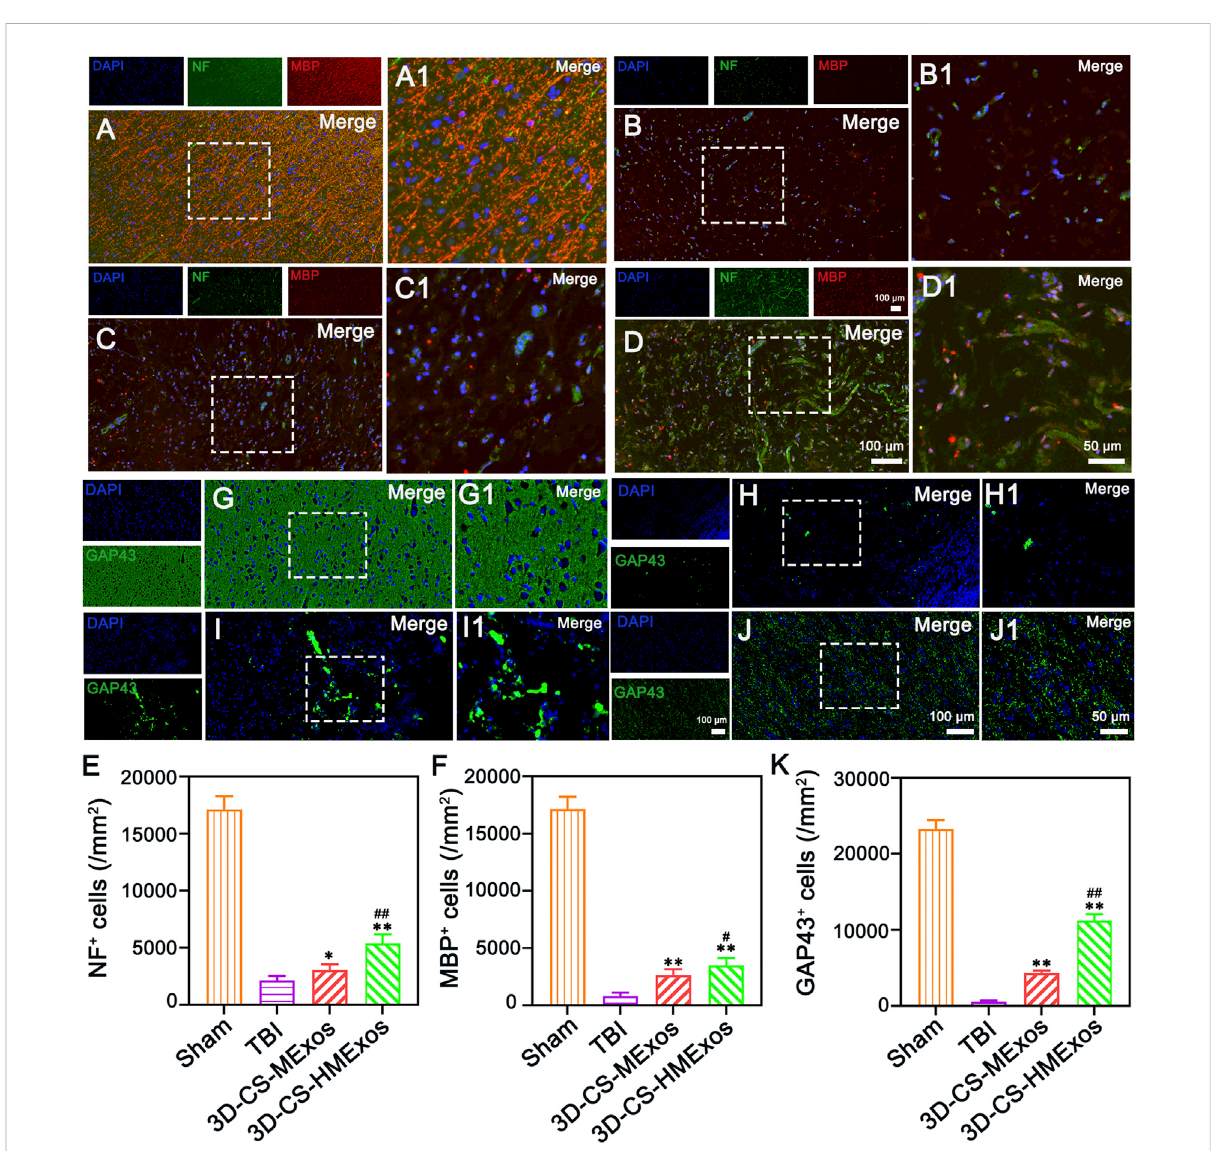
FIGURE 5 Nerve fi ber regeneration, myelination, and axonal outgrowth after TBI. (A – D) 6 months after TBI, the NF, and MBP staining results identi fi ed regenerated nerve fi bers that had undergone myelination. (E,F) Quanti fi cation of the relative density of NF- and MBP-positive cells in each group. (G – J) Axonal regeneration (GAP43 + ) was detected in lesion sites of canines treated with a hypoxia-modi fi ed exosome scaffold (3D-CS- HMExos). (K) Quanti fi cation of newborn axons in the lesion area of dogs among each group. The ampli fi cation views of the injured sites, in which the signals of NF, MBP, and GAP43 in regions between the black dotted bordered rectangle are presented in (A1), (B1), (C1), and (D1), respectively. The image on the right is an enlarged image of the image in the white box of the image on the left. * p < 0.05, ** p < 0.01 vs. TBI group. # p < 0.05, ## p < 0.01 vs. 3D-CS-MExos group, n =